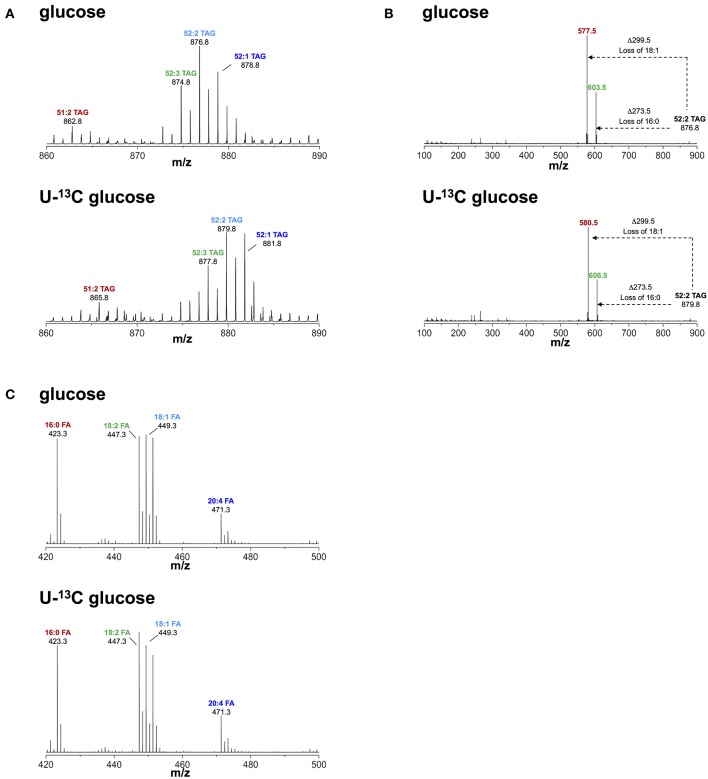
Metabolic fate of 13C-glucose in TAG. (A) ToF-MS profile of major TAG species in macrophages activated in medium containing unlabeled or U-13C glucose. A mass shift of 3 Da was observed in TAG species of macrophages activated in the presence of labeled glucose. (B) MS/MS of 52:2 TAG (m/z 876.5), a major TAG species. A mass shift of 3 Da remains after loss of fatty acid chains induced by collision fragmentation in macrophages activated in the presence of labeled glucose. (C) Fatty acid profile obtained from macrophages activated in medium containing unlabeled and U-13C glucose. There was no mass shift observed in fatty acids obtained from macrophages activated in medium containing U-13C glucose. Data is representative of three experiments.